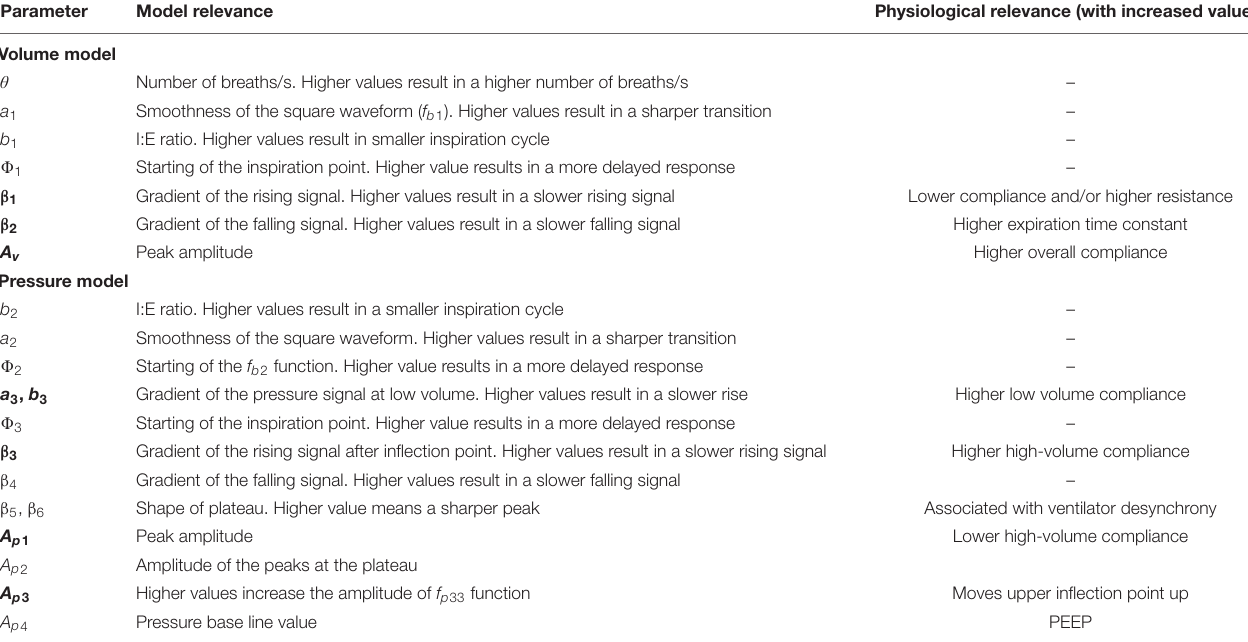
TABLE 1 | Interpreting damaged-informed lung ventilator model parameters. Parameter Model relevance Physiological relevance (with increased